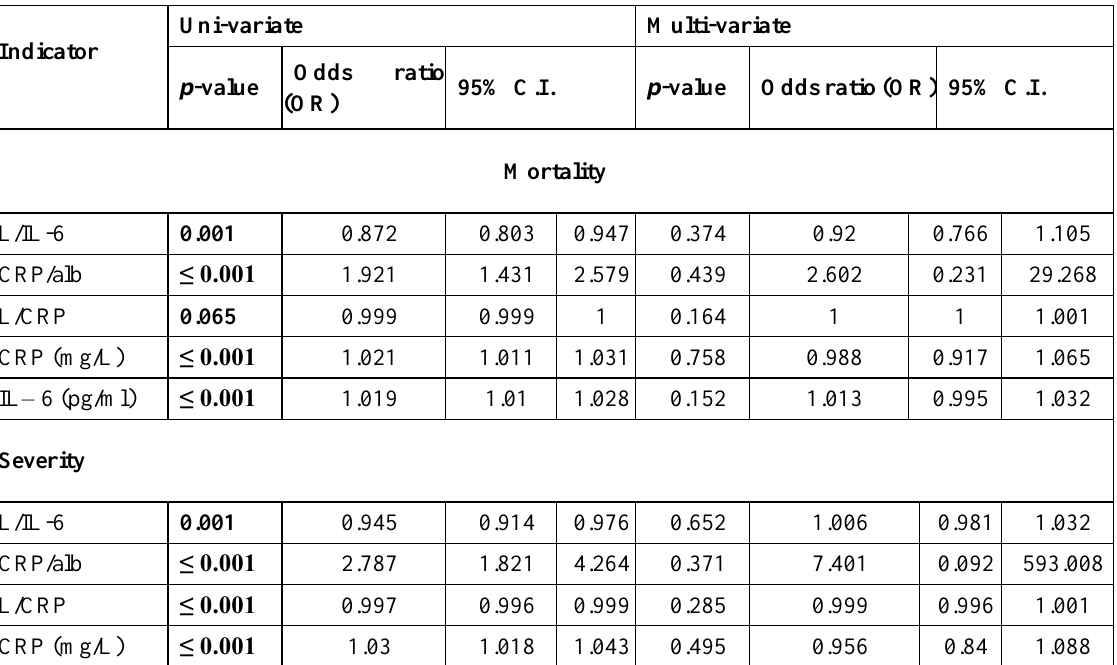
Table 4. Predictors of COVID-19 progression